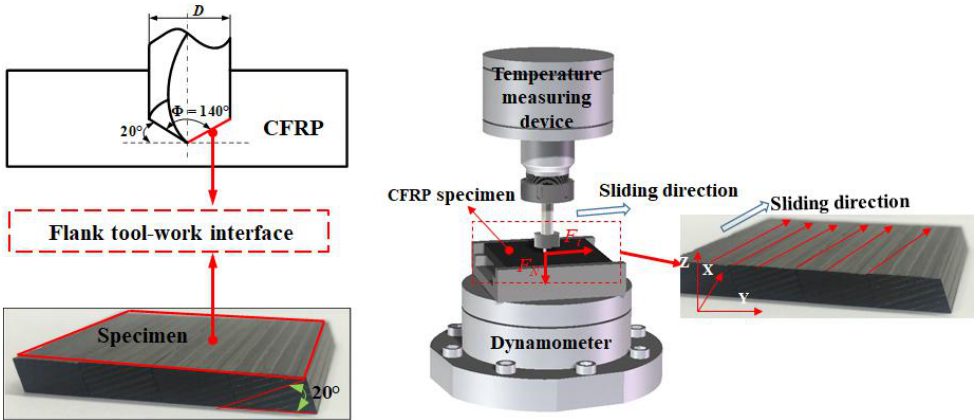
Figure 1. The specially-designed carbon fiber reinforced polymer (CFRP) plate for replicating the local friction conditions of drilling and the scheme of the pin-on-disc tests.